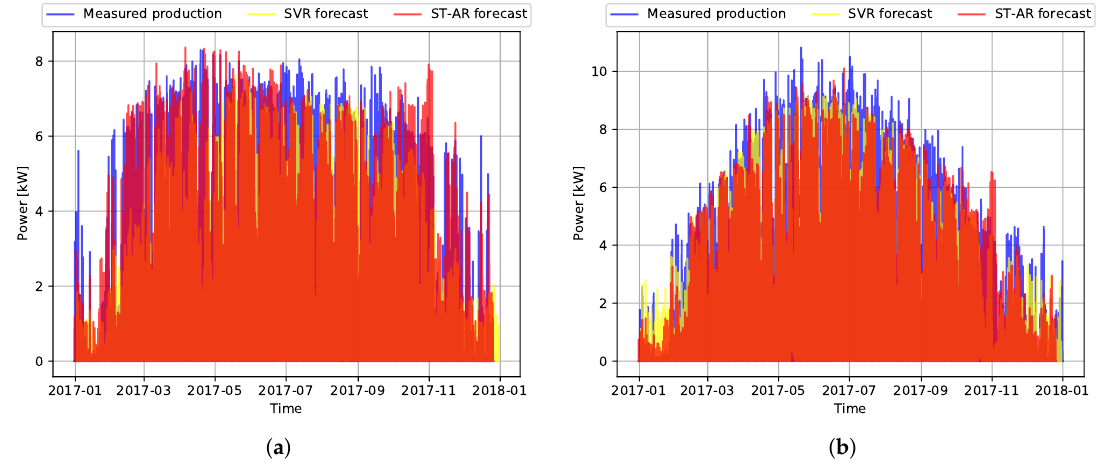
Figure 9. Illustration of the annual PV production for the selected sites. ( a ) Measured and forecasted production for Bern. ( b ) Measured and forecasted production for Bätterkinden. The forecasts are done every six hours with a horizon of six